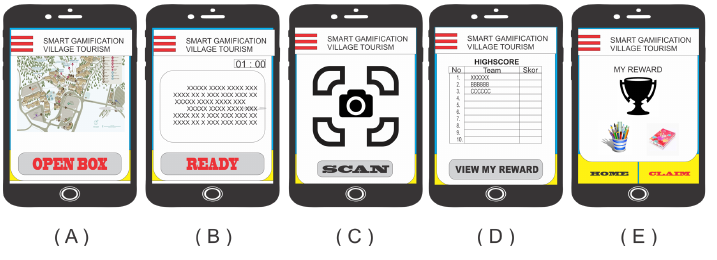
Fig. 6. Advanced Workflow Captain